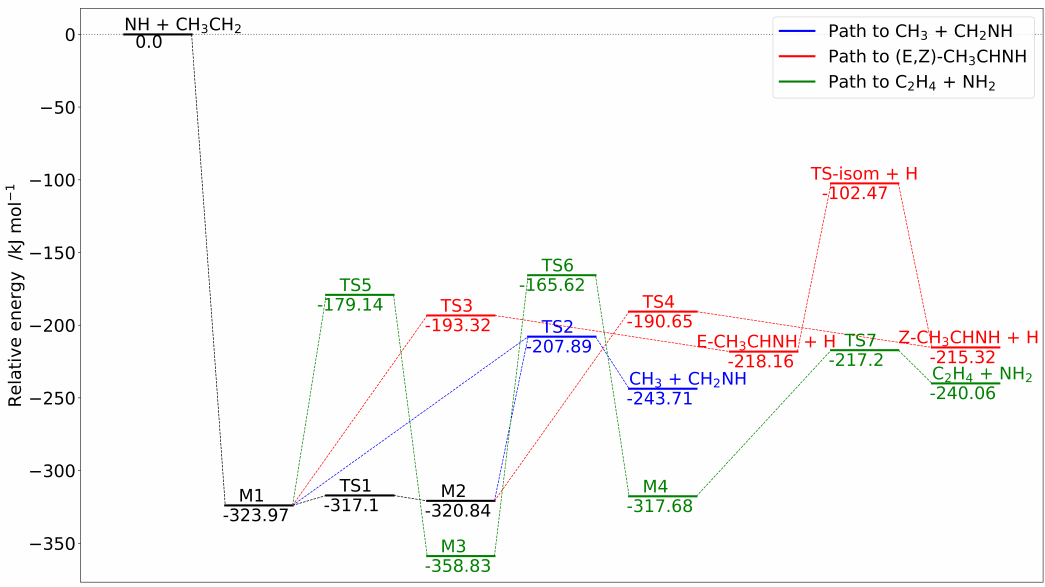
Figure 3. Reaction mechanisms for the NH + C 2 H 5 reaction: complete basis set (CBS)+core-valence (CV) energies augmented by B2 anharmonic zero-point vibrational energies